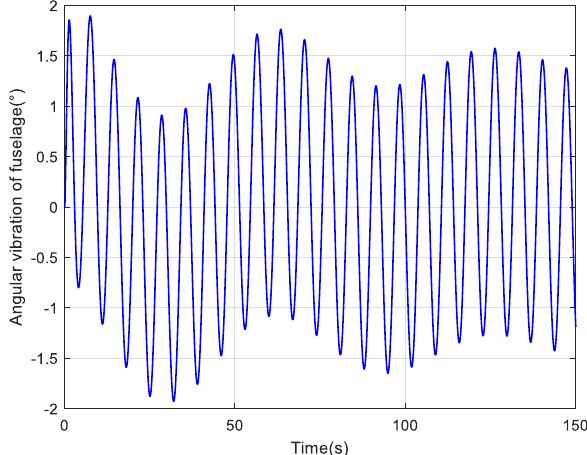
Figure 7. The curve of line angular of roadheader.